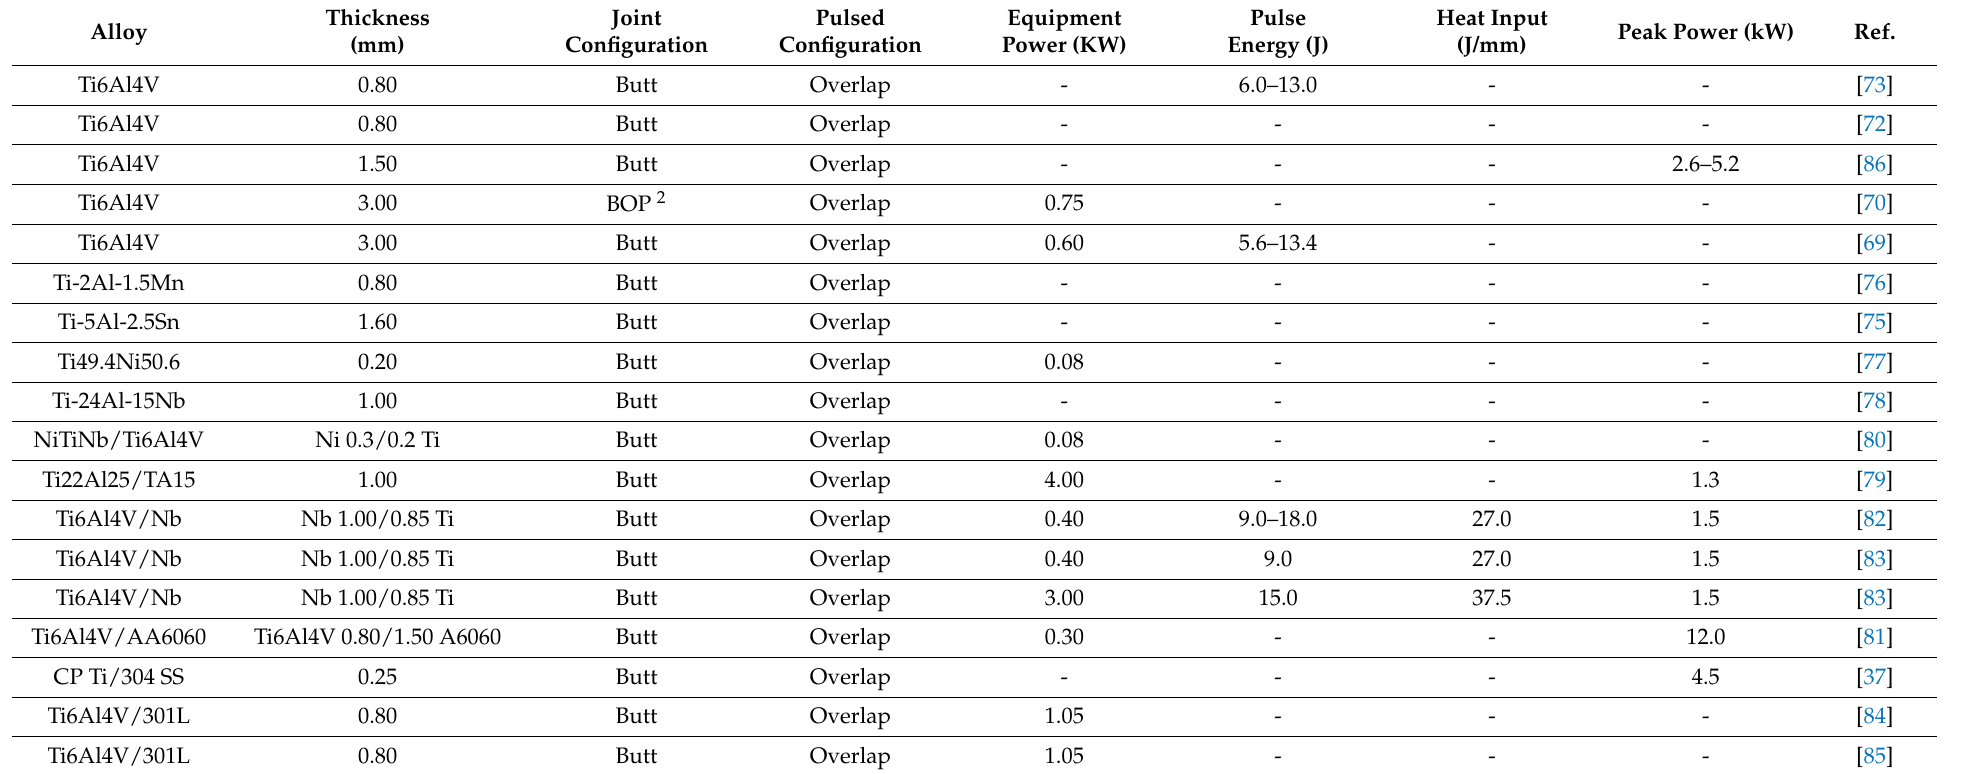
Table 5. Details of welding conditions applied to titanium pulsed laser 1